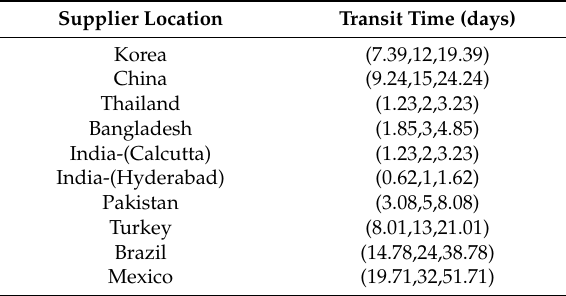
Table 3. Transit time from suppliers.